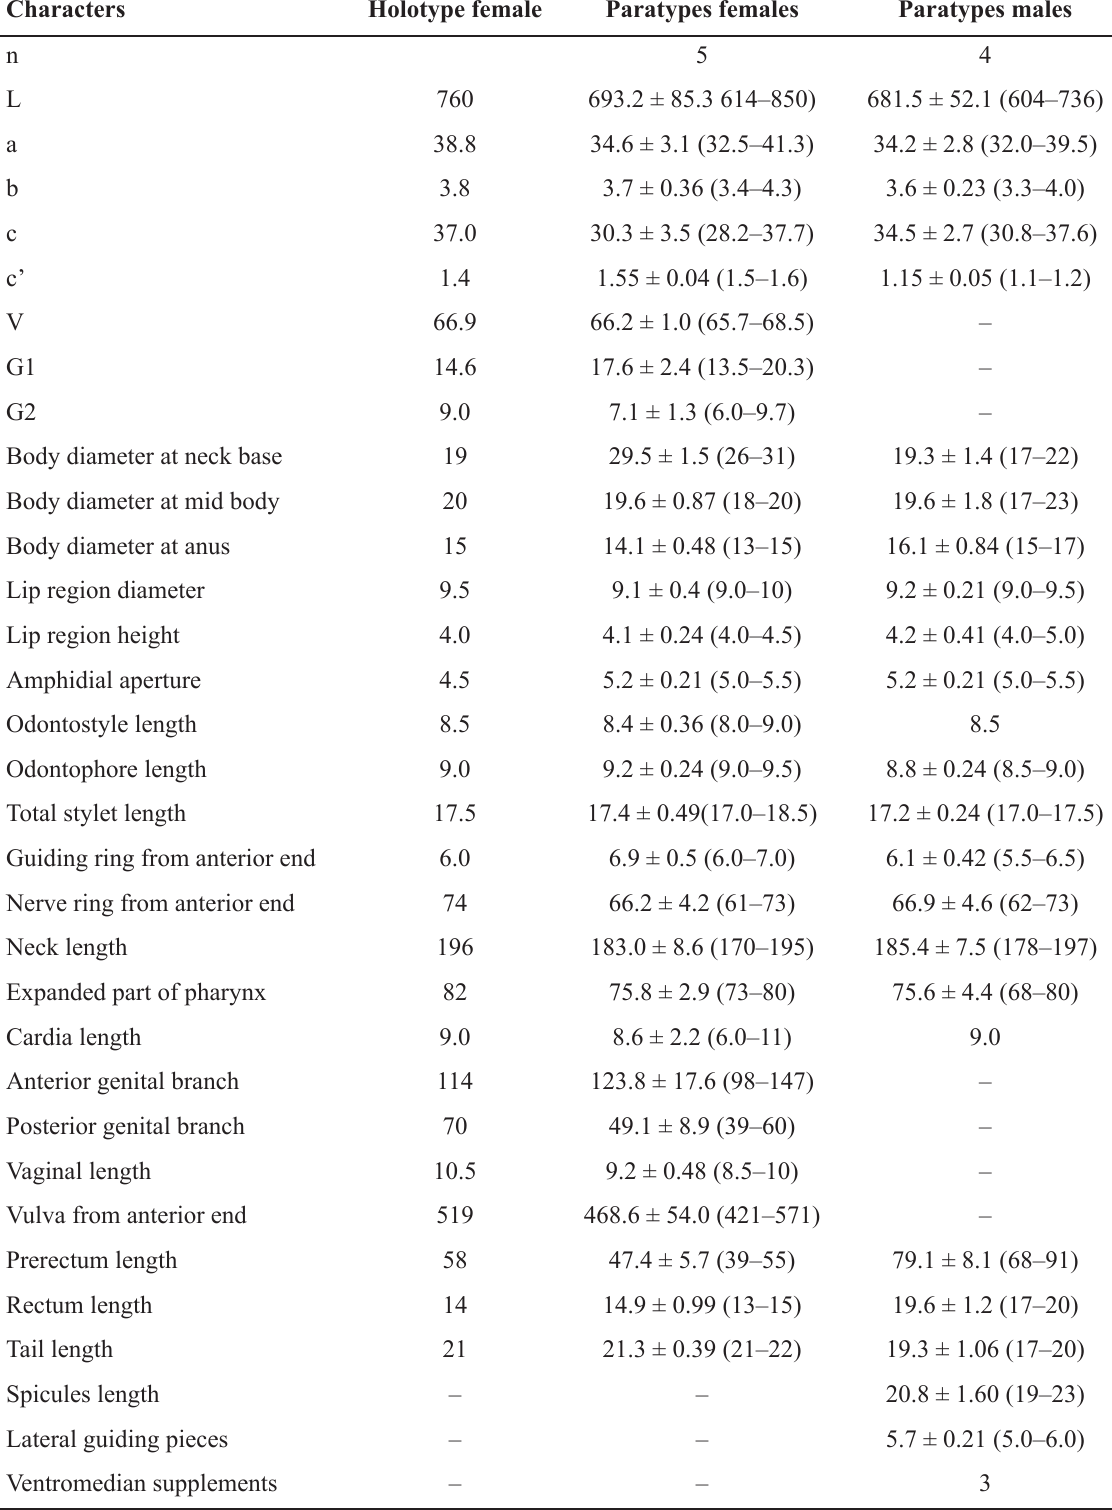
Table 6. Measurements of Tylencholaimus macroamphidius sp. nov. All measurements are in µm and in the form: mean ± s.d.